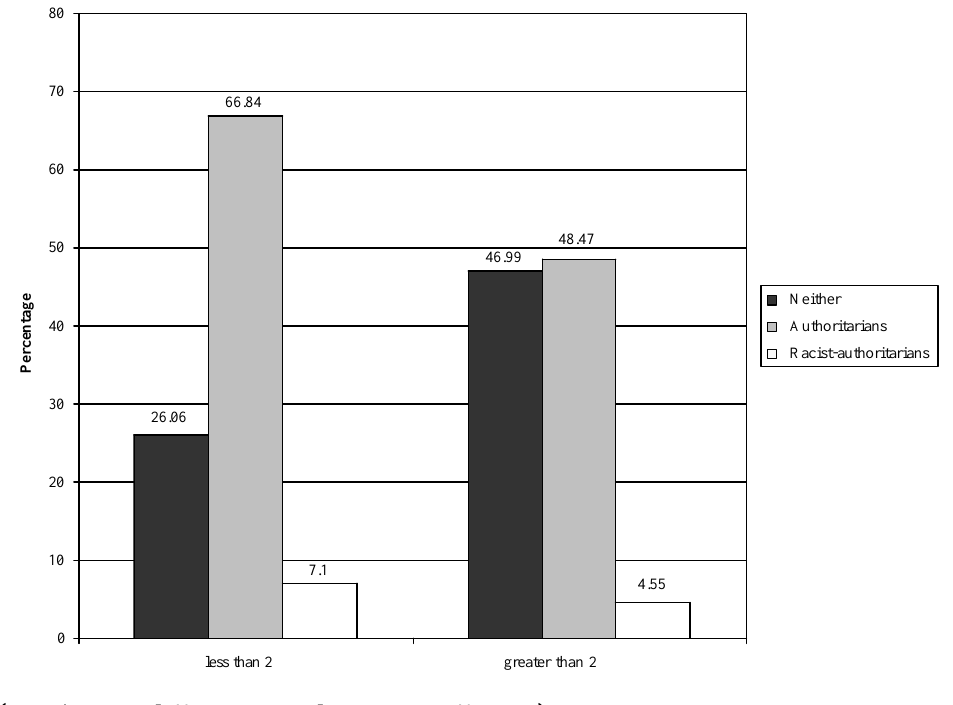
Figure 2. Cluster type by qualification